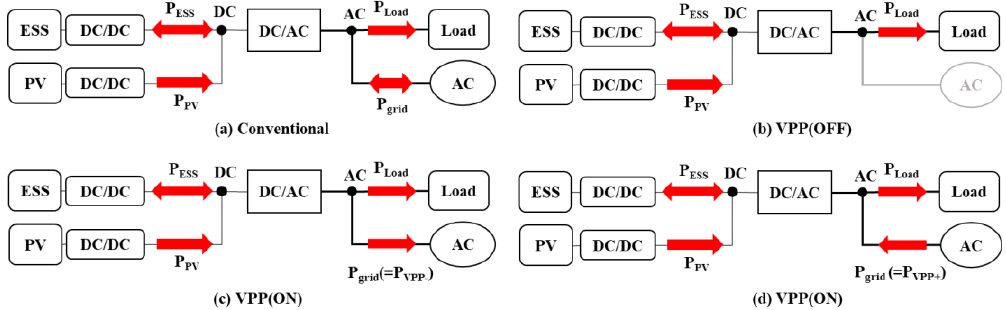
Figure 5. Comparison between the conventional and proposed operations.